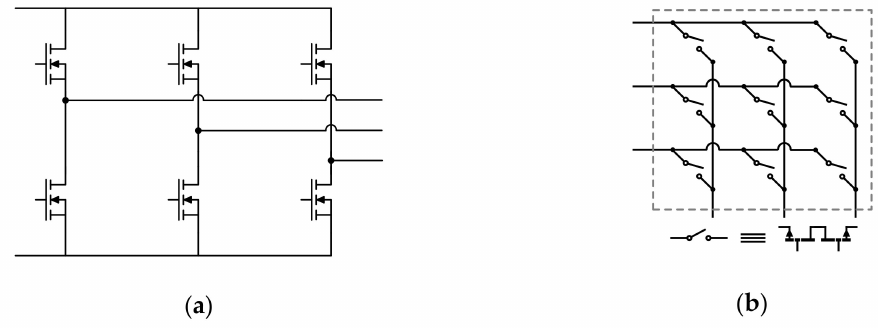
Figure 1. Power converter circuit for variable frequency drive (VFD). ( a ) Conventional two-level inverter; ( b ) Matrix